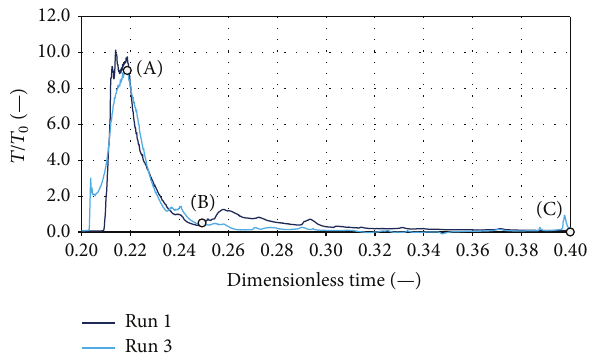
Figure 12: Dimensionless resistant torques during the second impact: run 1 versus run